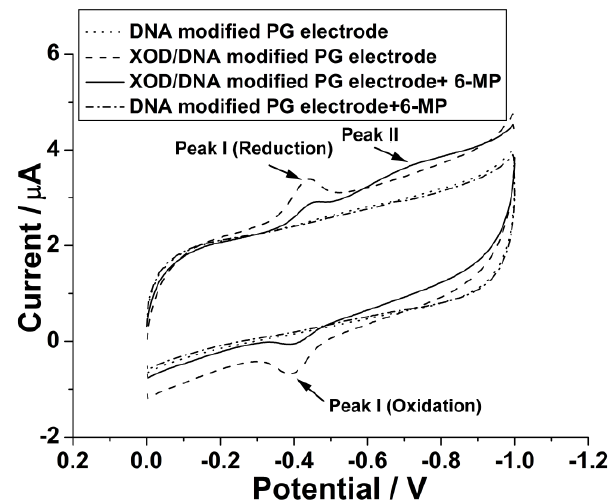
Figure 1. Cyclic voltammograms obtained at DNA and xanthine oxidase (XOD)/DNA modified electrode in the absence and presence of 200 μM 6-MP in 0.1 M pH 7.4 phosphate buffers. Scan rate: 100